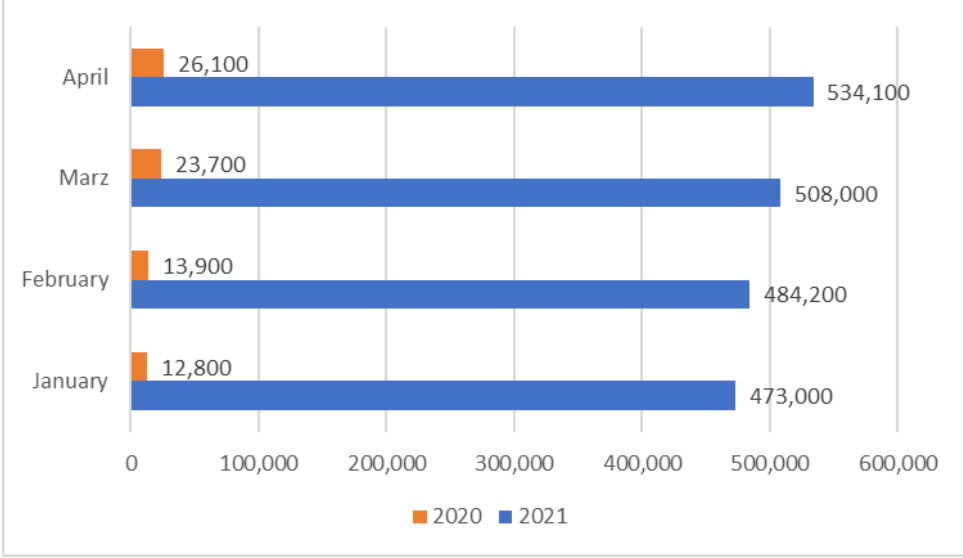
Figure 2. Increase in the number of PV installations on rooftops Source: Based on data from the Energy Market Agency (June 2021). In 2020 alone, 2635 megawatts (MW) of solar energy were installed in Poland — three times more than in 2019 (823 MW). According to the European association of the